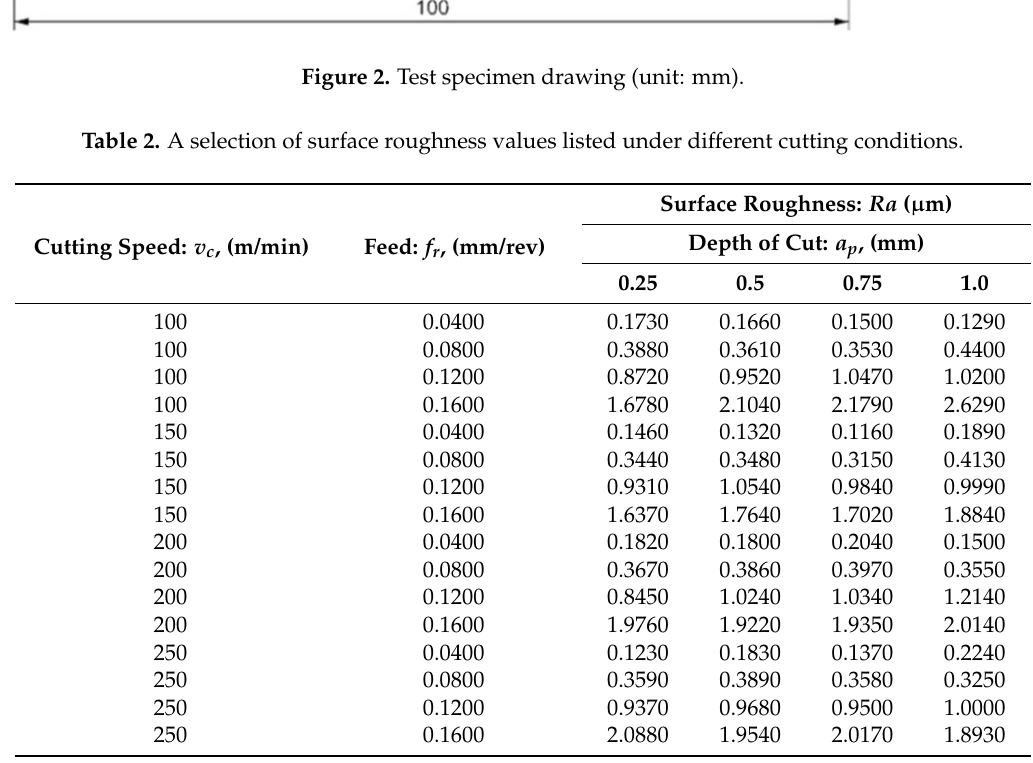
Table 3. Summary of basic economic parameters.